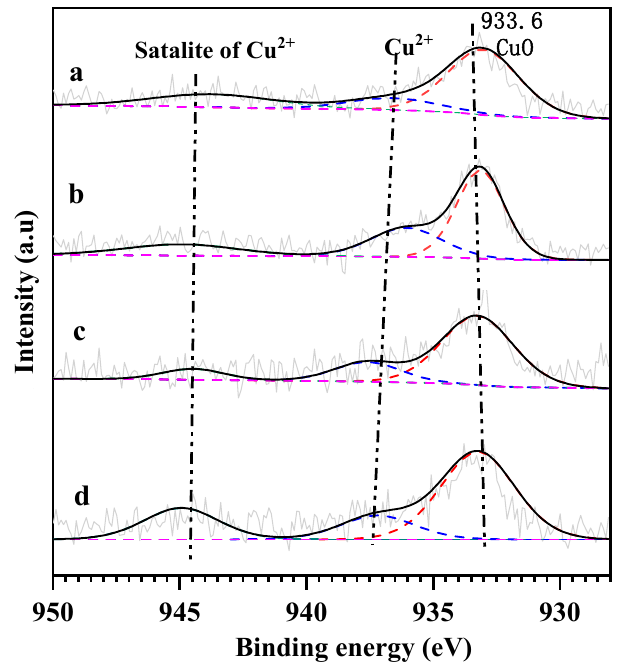
Figure 3. Cu 2p3 / 2 XPS spectra of the fresh and sulfated samples: ( a ) Cu-SAPO-18, ( b ) Cu-SAPO-18-S, Figure 3. Cu 2p3/2 XPS spectra of the fresh and sulfated samples: ( a ) Cu-SAPO-18, ( b ) ( c ) Ce-Cu-SAPO-18, and ( d ) Cu-SAPO-18-S, ( c ) Ce-Cu-SAPO-18, and ( d ) Ce-Cu-SAPO-18-S.